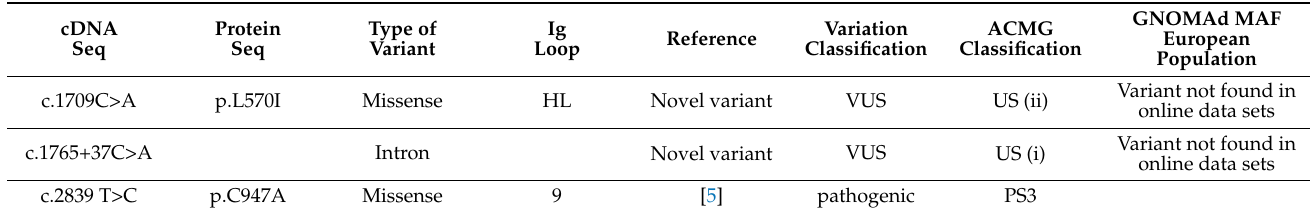
Table 1. Overview of variants found in the extracellular regions of ISGF1 in 94 Dutch patients with a combination of CeH and growth hormone deficiency. VUS = Variance of uncertain significance; HL = Hydrophobic linker domain.